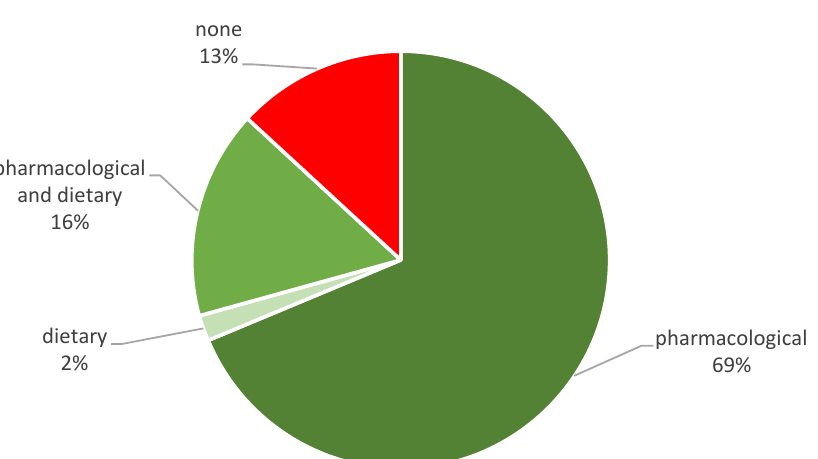
Figure 3. Recommendation of lipid-lowering therapy in the epicrisis of the doctors’ reports. Four different recommendation options are displayed: pharmacological advice (dark green), dietary advice (light green), both pharmacological and dietary advice (green), no advice (red). Values are shown in %.